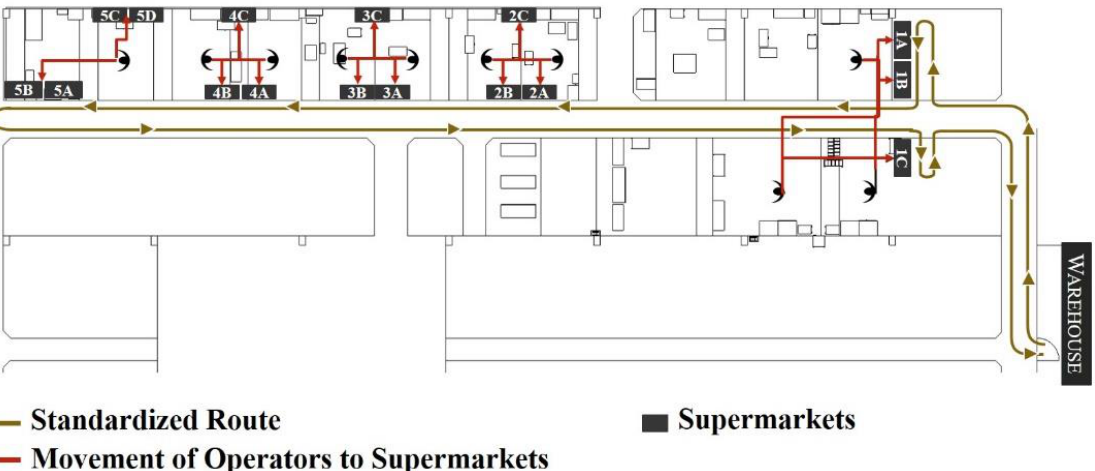
Figure 10. Representation of operators’ movements after the implementation of improvement